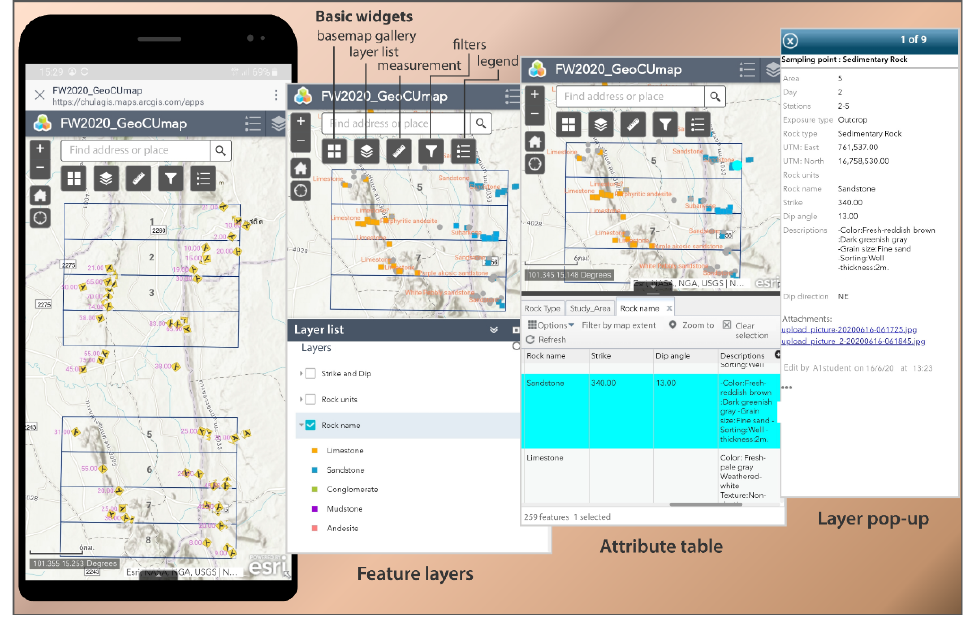
Figure 3. An interface and screenshot from a smartphone display of the web map application. Users can turn on/off feature layers by clicking on the layer names. On the attribute table panel, specific stations can be selected from the table, which will show the selected feature simultaneously on a map (a cyan dot corresponding to a selected attribute in cyan color). In addition, detailed survey information at each station can be shown as a pop-up window when the user clicks on a point feature on the map.